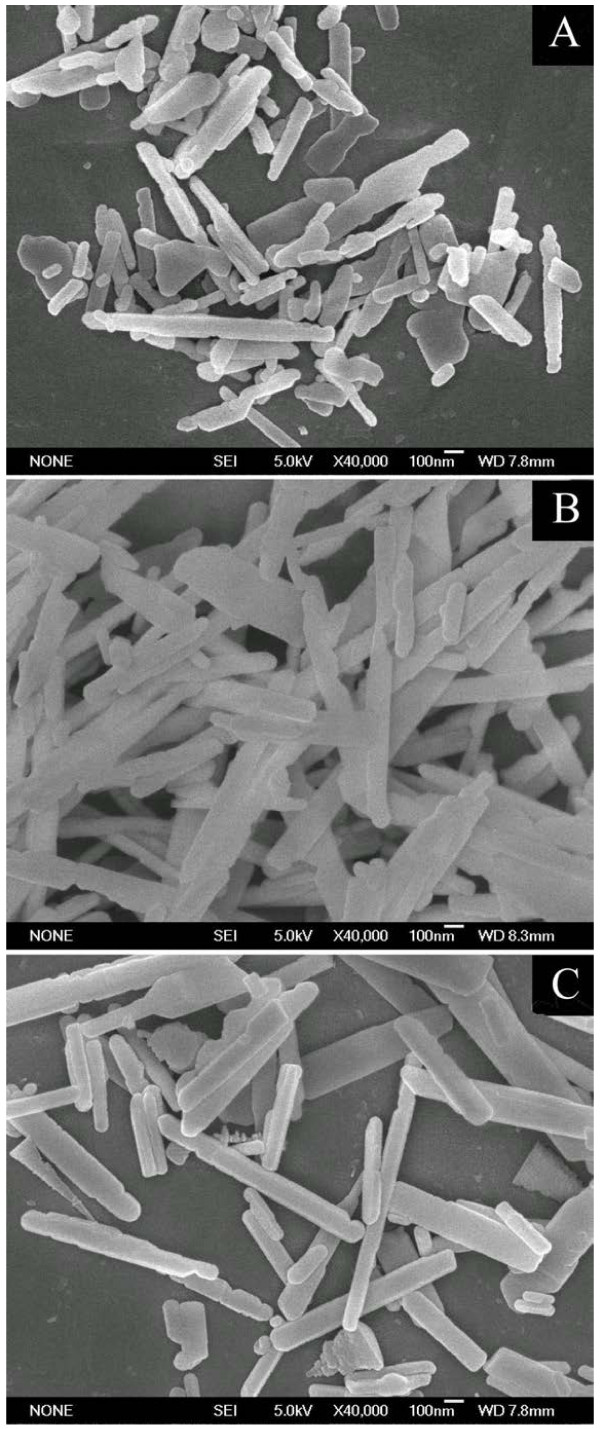
SEM images of as-synthesized SrCO3particles at 50°C with different molar ratios of methanol/water. (A) 3:2, (B) 1:1, (C) 2:3.